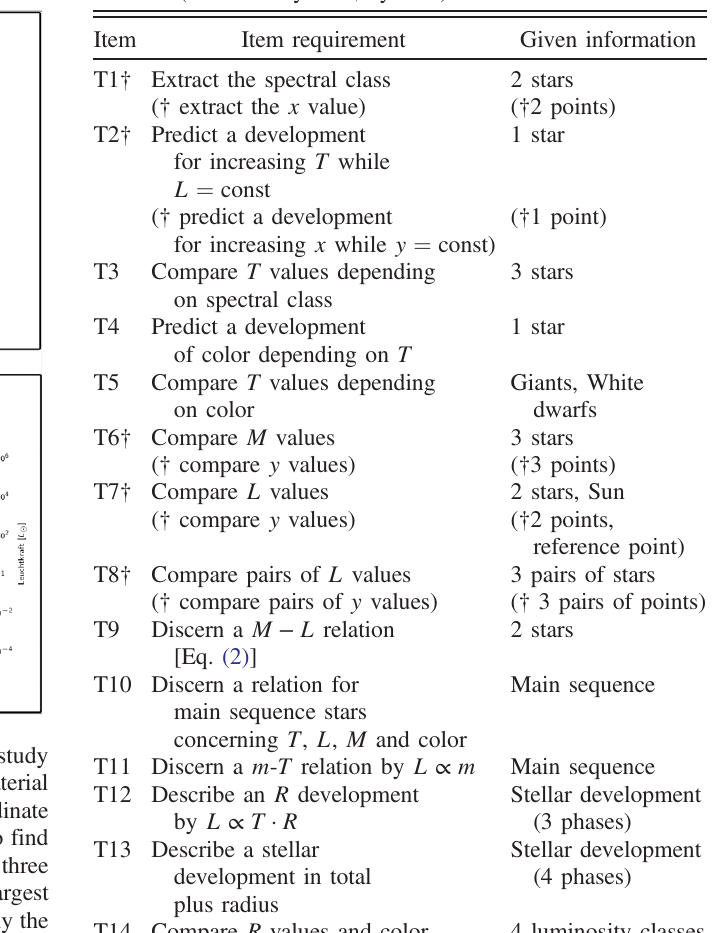
TABLE IV. A description of the 14 items related to the